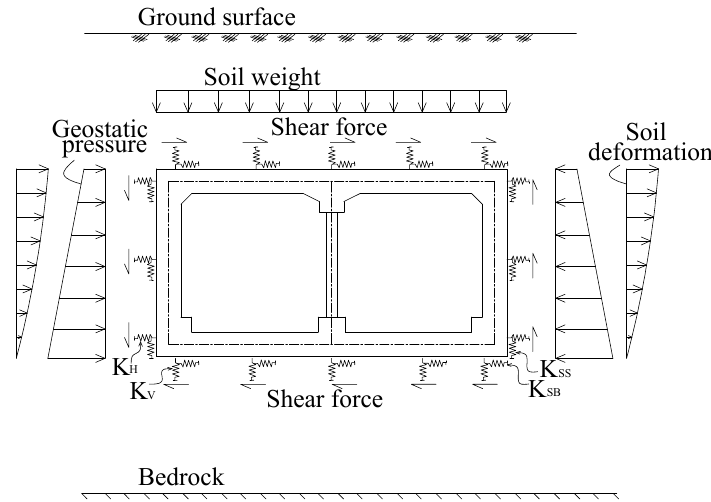
Figure 3. Boundary conditions and applied loads to the box tunnel.